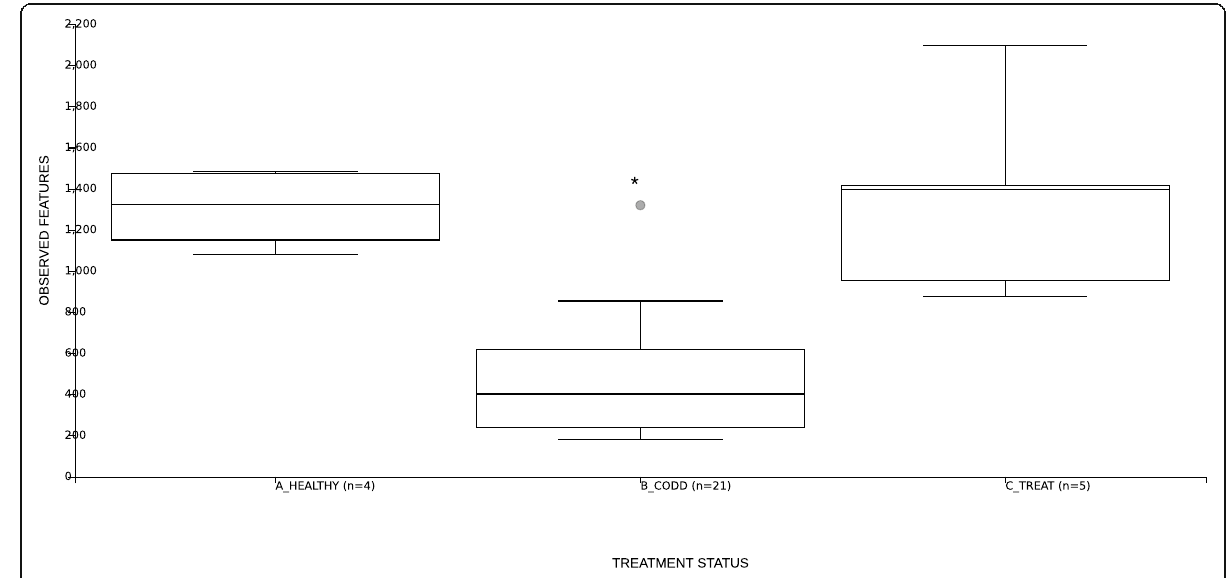
Fig. 7 Box and whisker plots of alpha diversity as measured by observed ASVs for samples taken from healthy (A_Healthy), CODD affected